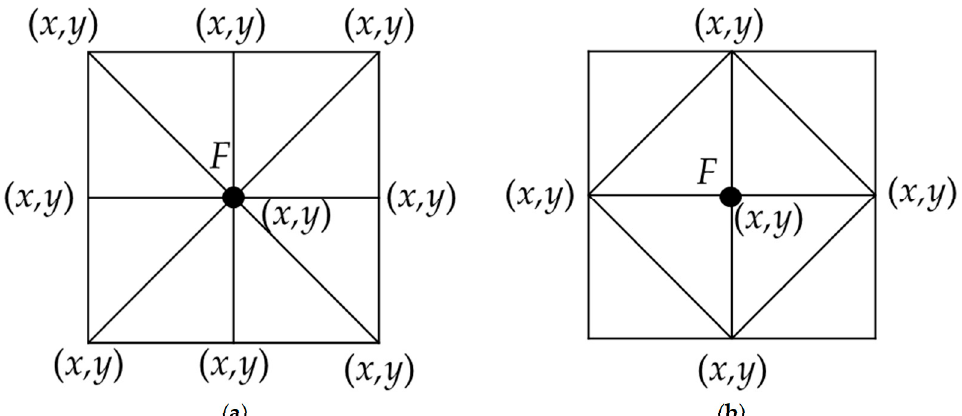
Figure 2. Parameters appear in partial derivative of objective function with respect to x - and y -coordinates of vertex F : ( a ) maximum number of parameters; ( b ) minimum number of parameters.